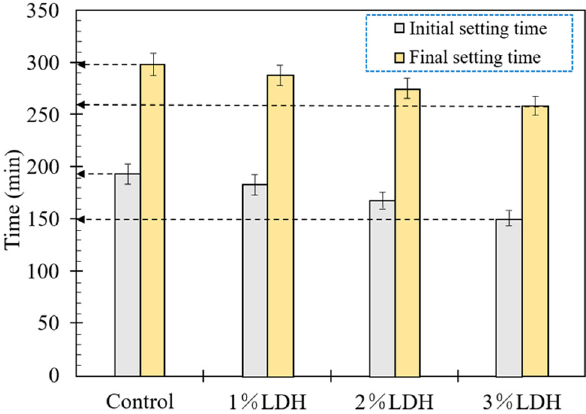
Figure 7: E ff ect of LDHs on setting time of cement paste [ 106 ]